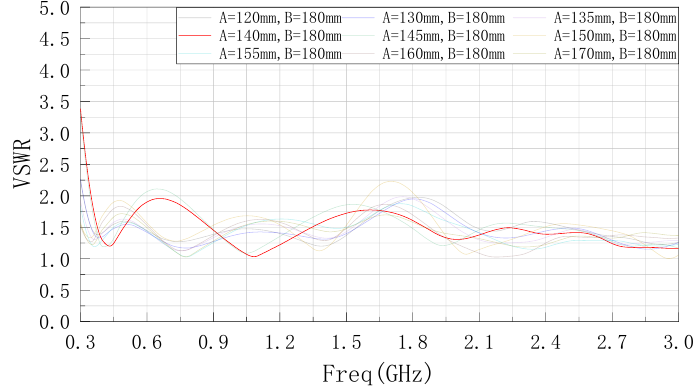
Figure 4. VSWR curve after optimized parameter A.